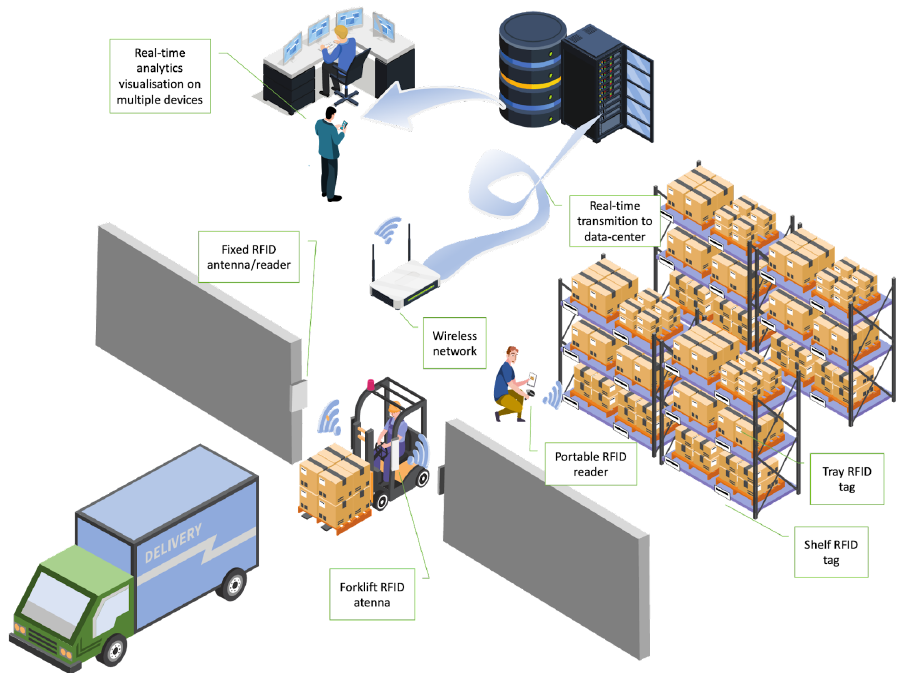
Figure 5. The concept of RFID-based warehouse management